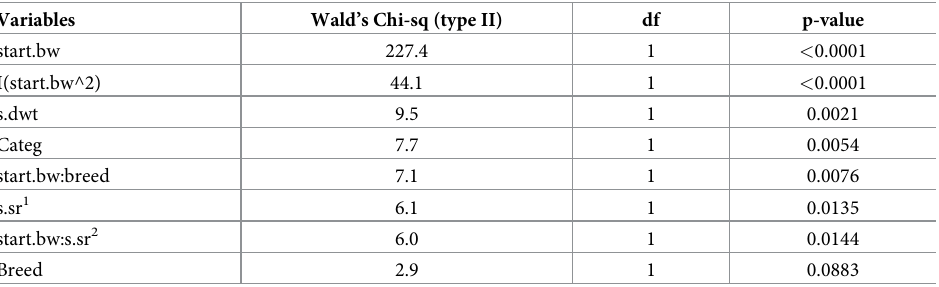
Table 4. Analysis of variance of the pregnancy rate model with proximate factors and stocking rate.